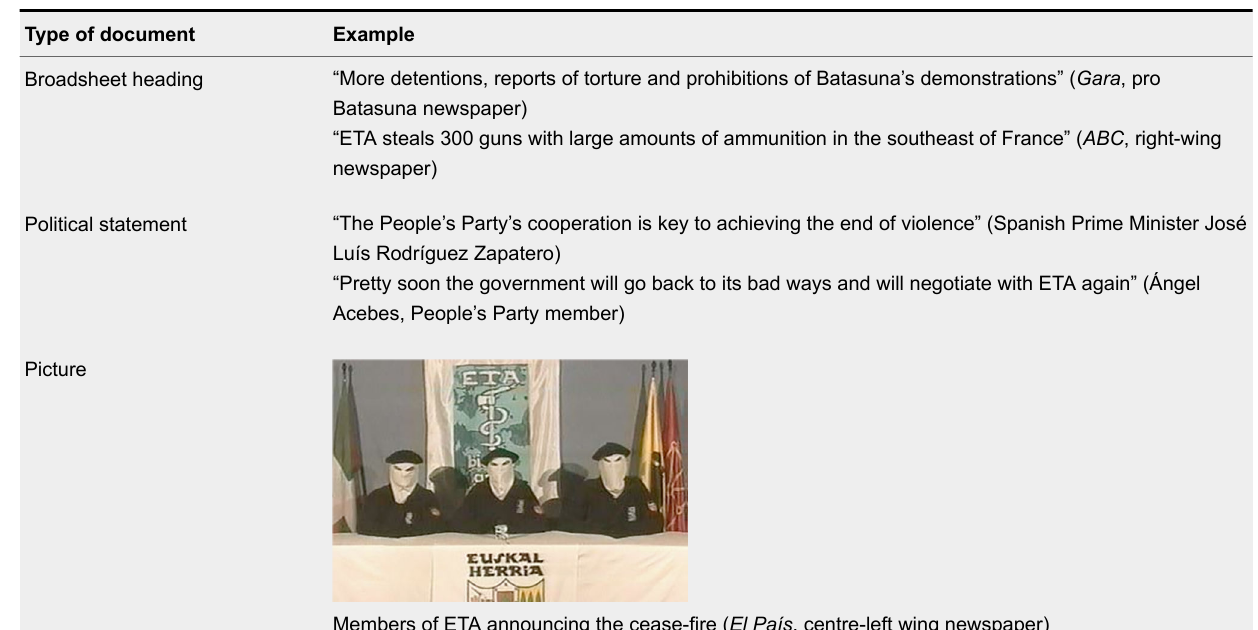
Examples of the Different Type of Documents Provided to